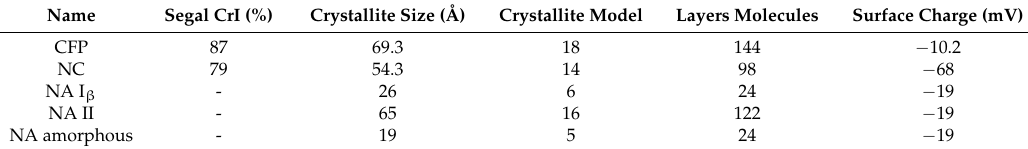
Table 1. The crystallinity index values, crystallite size values, and crystallite model for the